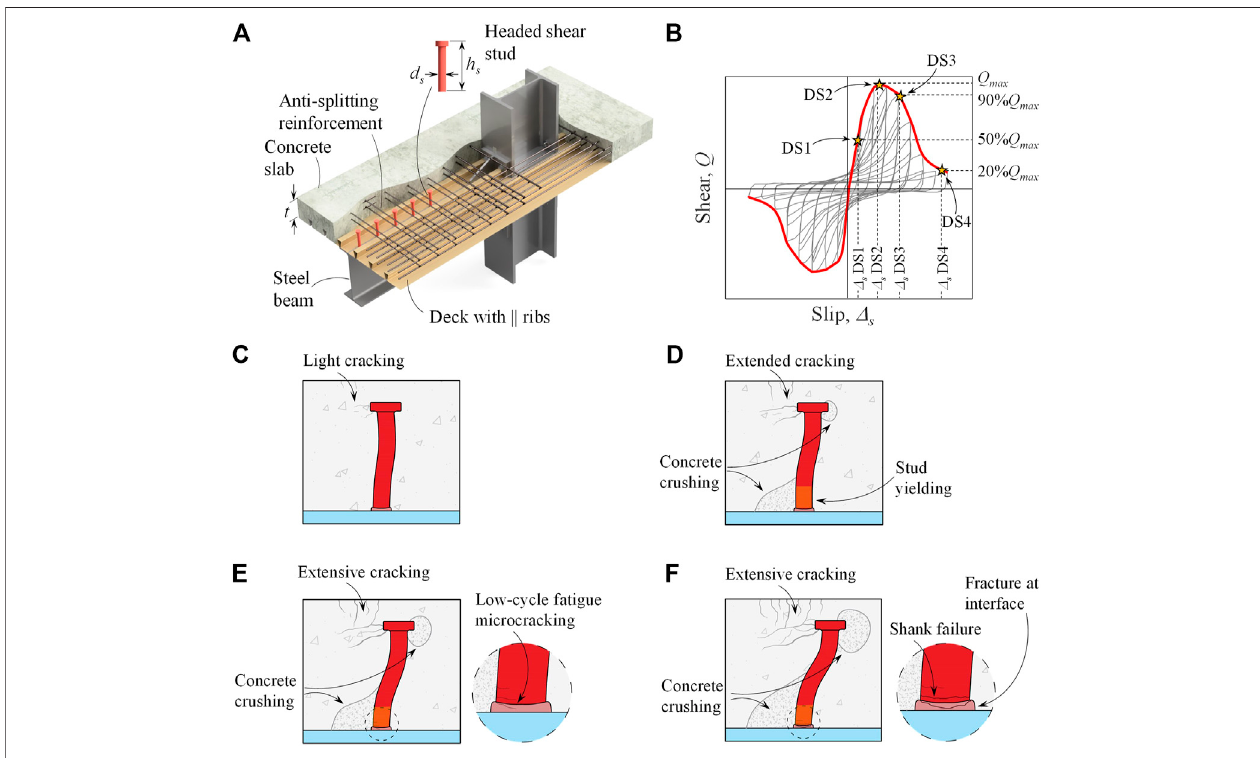
FIGURE2| Observeddamageincyclicpush-outtests (A) DS2:Extendedcrackingintheslabmeasuredusingdigitalimagecorrelation(DIC)(ElJisretal.,2021) (B) DS3: Extensive cracking in the slab (image from Zandonini and Bursi, 2000) (C) DS4: Loss of shear load carrying capacity/fracture of weld collar (El Jisr et al., 2021) (D) DS4: Loss of shear load carrying capacity/shearing of headed studs (El Jisr et al., 2021).